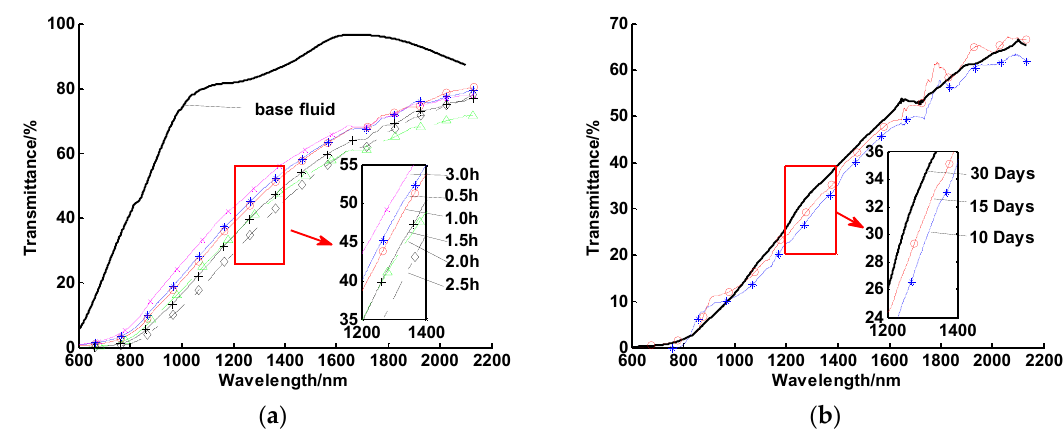
Figure 9. Spectral transmittances of CuO/oil nanofluids for ( a ) different periodic resonication times and ( b ) different settling times (10, 15, and 30 days).